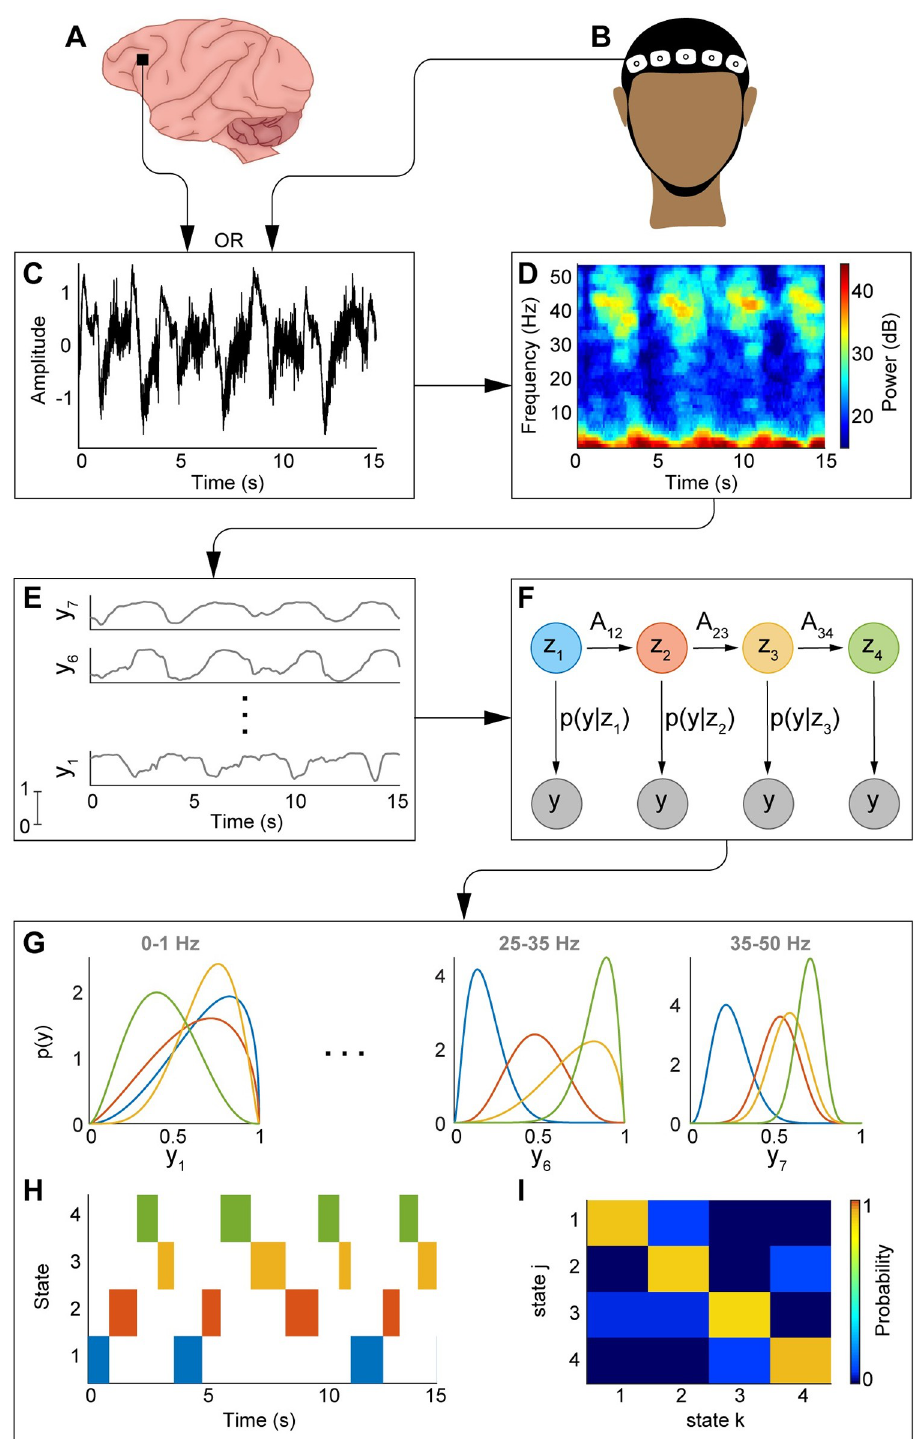
Fig 1. Schematic of the beta-HMM algorithm. Neural recordings from primate LFP (A) or human EEG (B) serve as inputs to the algorithm. Electrical recordings (C) are converted to their time-frequency representation via multitaper spectral analysis (D). The spectral observations are split into 7 frequency bands and scaled between 0 and 1 (E). These observations are then fit to the beta-HMM (F) via the EM algorithm, and the state trajectory is estimated from the Viterbi algorithm. Outputs of the algorithm are the beta observation distributions for each state (G), estimated state trajectory (H), and a transition matrix (I) describing the state switching dynamics.